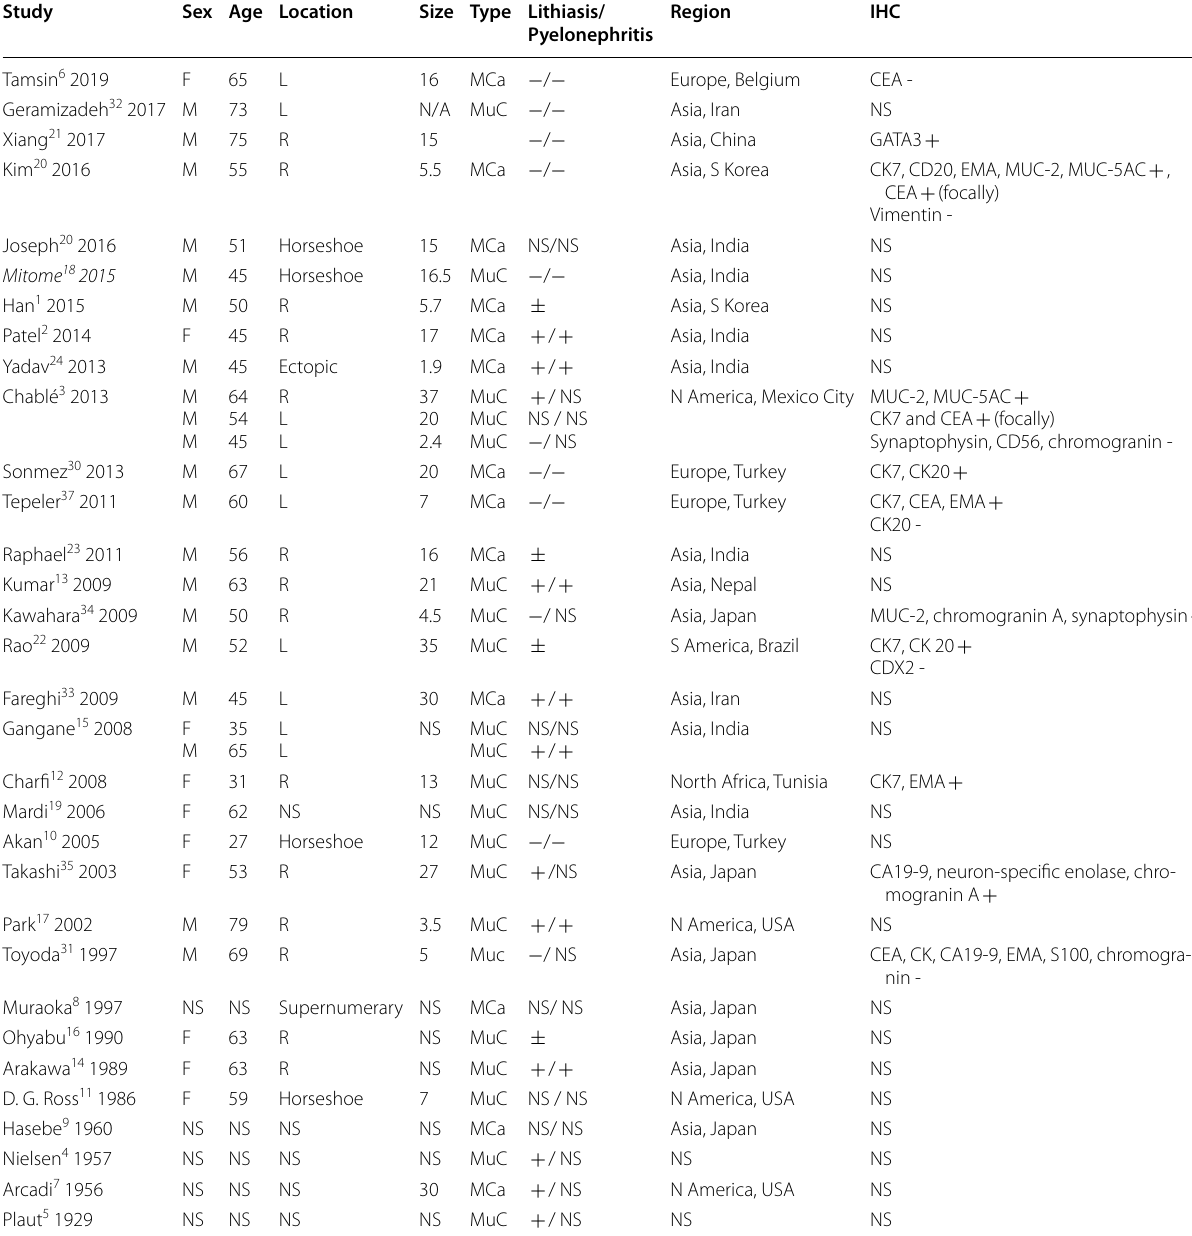
Table 2 Previous case reports on MC and